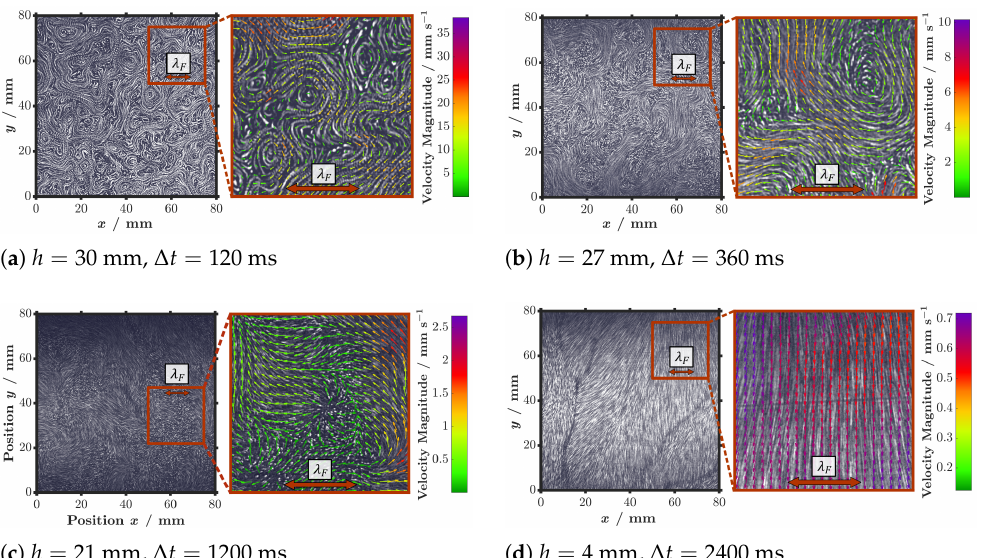
Figure 3. Visualization of tracer particles at different horizontal planes at a forcing acceleration of a f = 0.47 g. The particle streaks are obtained by averaging subsequent raw particle images over time span ∆ t . The enlargement panels further show the overlaid corresponding instantaneous velocity fields from the central frame. Note the presence of positive divergence in panel ( c ) as velocity vectors point outwards from the source point, indicating the presence of a downward pushing jet. Corresponding presentation for a f = 0.70g is in Supplementary Figure S4. Color online.